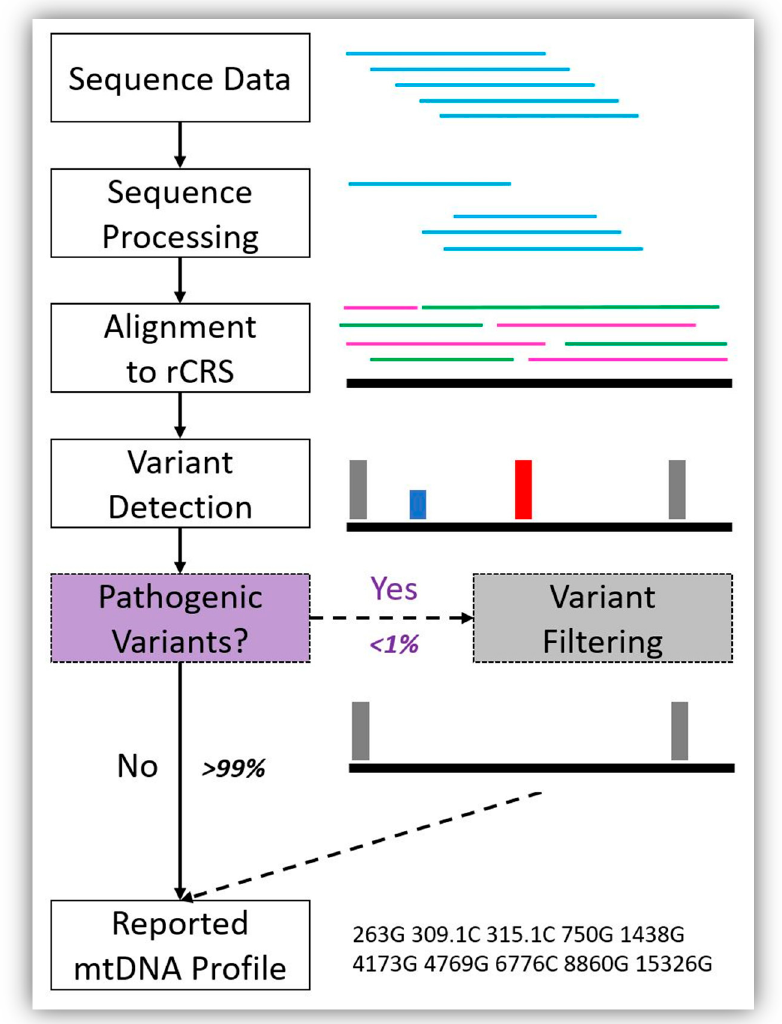
Figure 2. Example bioinformatics workflow showing the addition of pathogenic variant filtering to the analytical process for forensic mitochondrial genome (mitogenome) haplotype reporting. Sequence data are produced, processed, and aligned to the revised Cambridge Reference Sequence (rCRS) [11] for variant detection. Then, pathogenic variant filtering will be automatically performed before the mitochondrial DNA (mtDNA) profile is reported. Here, the pathogenic variants are depicted in red (homoplasmic) and blue (heteroplasmic), and both are filtered. Our results indicate that less than 1% of mtDNA haplotypes will require pathogenic variant filtering and the remaining 99% of mtDNA haplotypes will remain unchanged because they lack pathogenic variants.